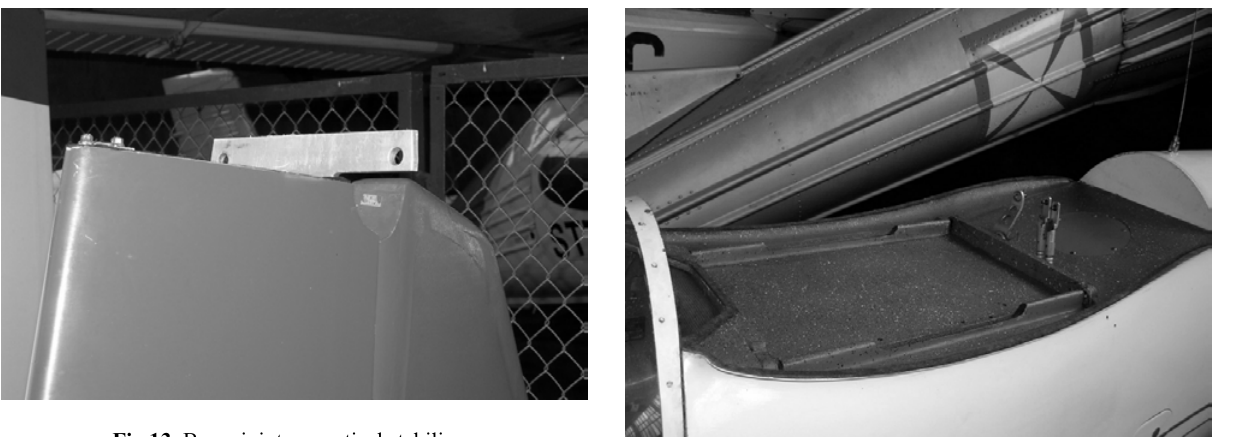
Fig 13. Beam joint on vertical stabilizer